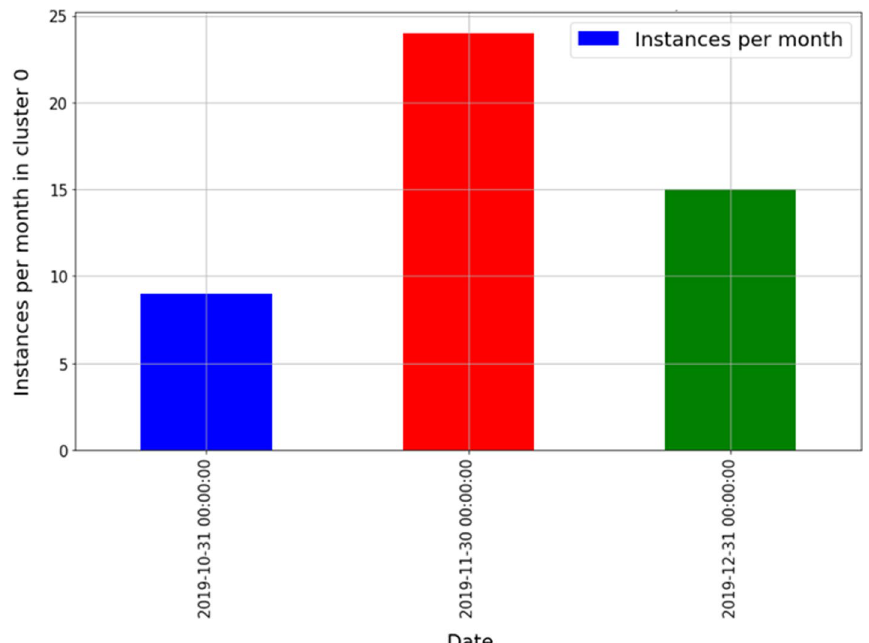
Fig. 17 Monthly distribution of electricity profile instances in cluster 0 for the 2019 dataset (48 samples in total). Note: the x-axis dates represent the entire, specific month